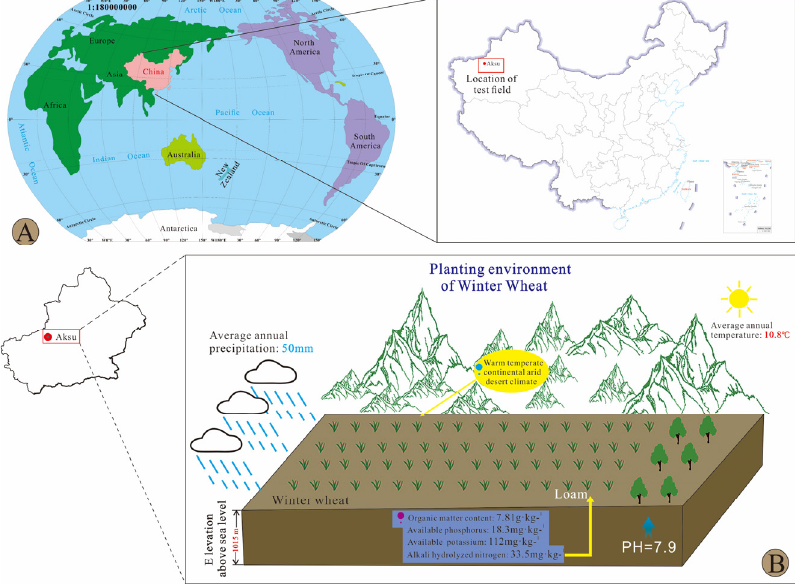
Figure 1. Introduction of Test Field. ( A ) The geographical location of the study area. ( B ) Growth environment model of winter